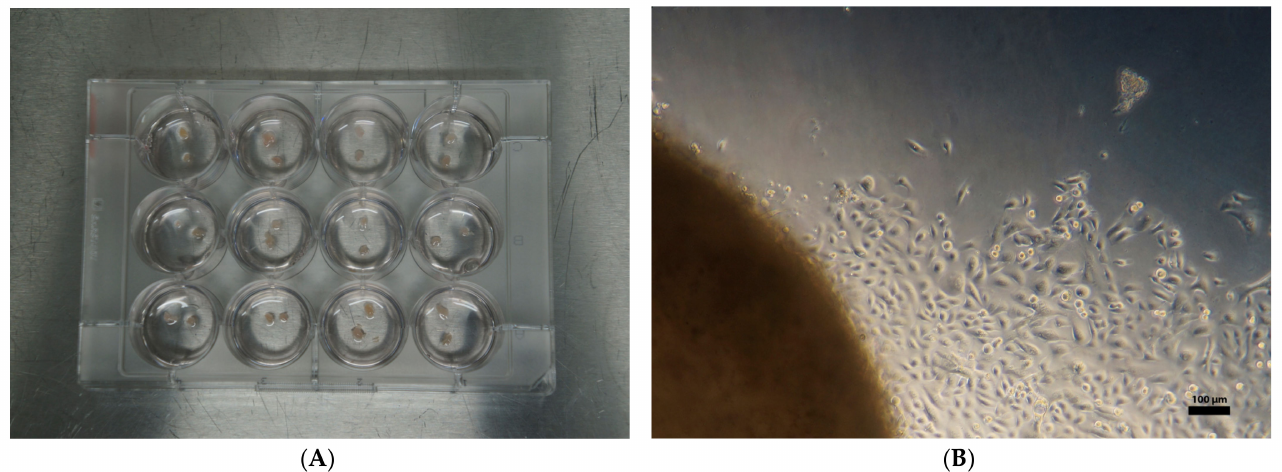
Figure 7. Isolation of epithelial cells using the outgrowth technique. Per sample, 24 small tissue pieces were cultured in a 12-well plate for the isolation of epithelial cells by outgrowth ( A ). Epithelial cell outgrowth ( B ) was evaluated microscopically every 2 days up to 8